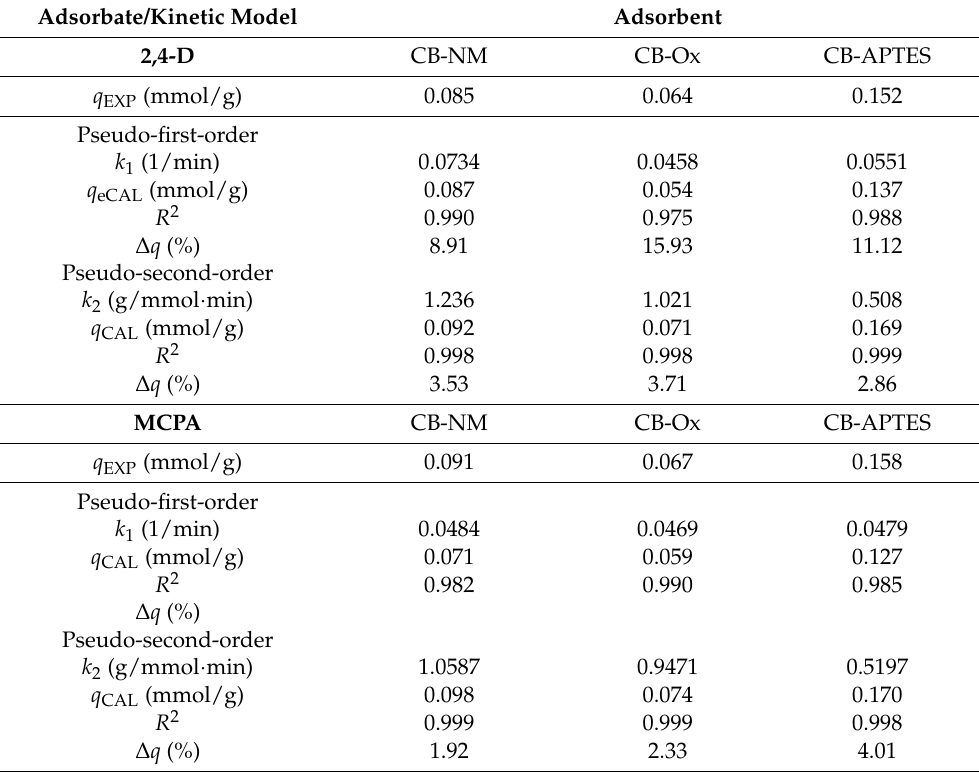
Table 4. Kinetic modeling data for adsorption of 2,4-D and MCPA on carbon black